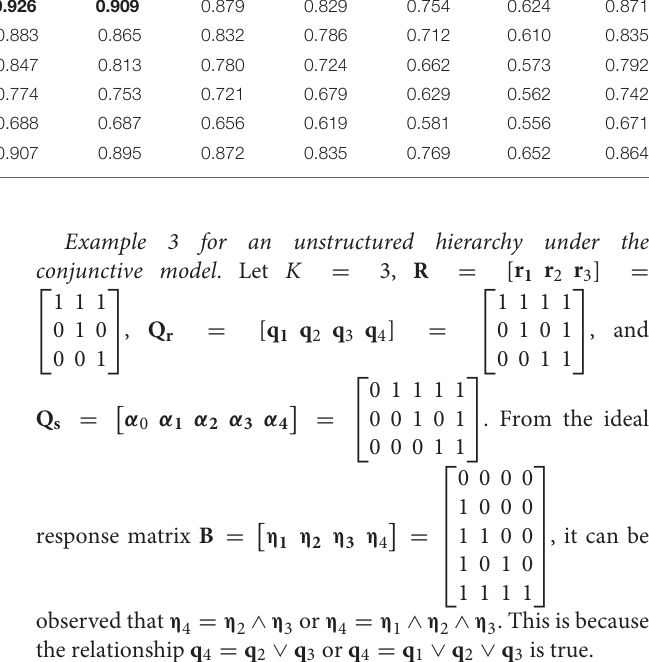
Item parameters for the new